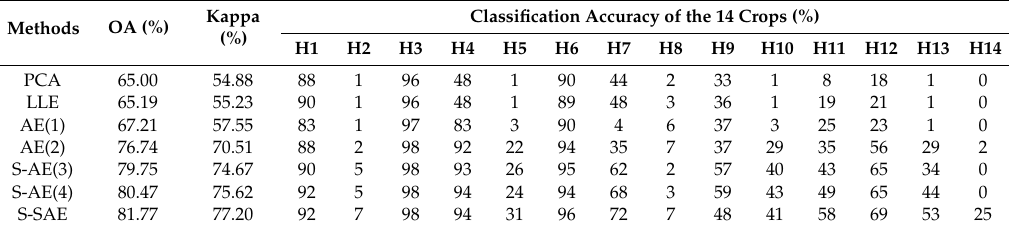
Table 5. Comparison of the support vector machine (SVM) classification accuracy with di ff erent dimension reduction methods for the Indian Head site. PCA: Principle component analysis.